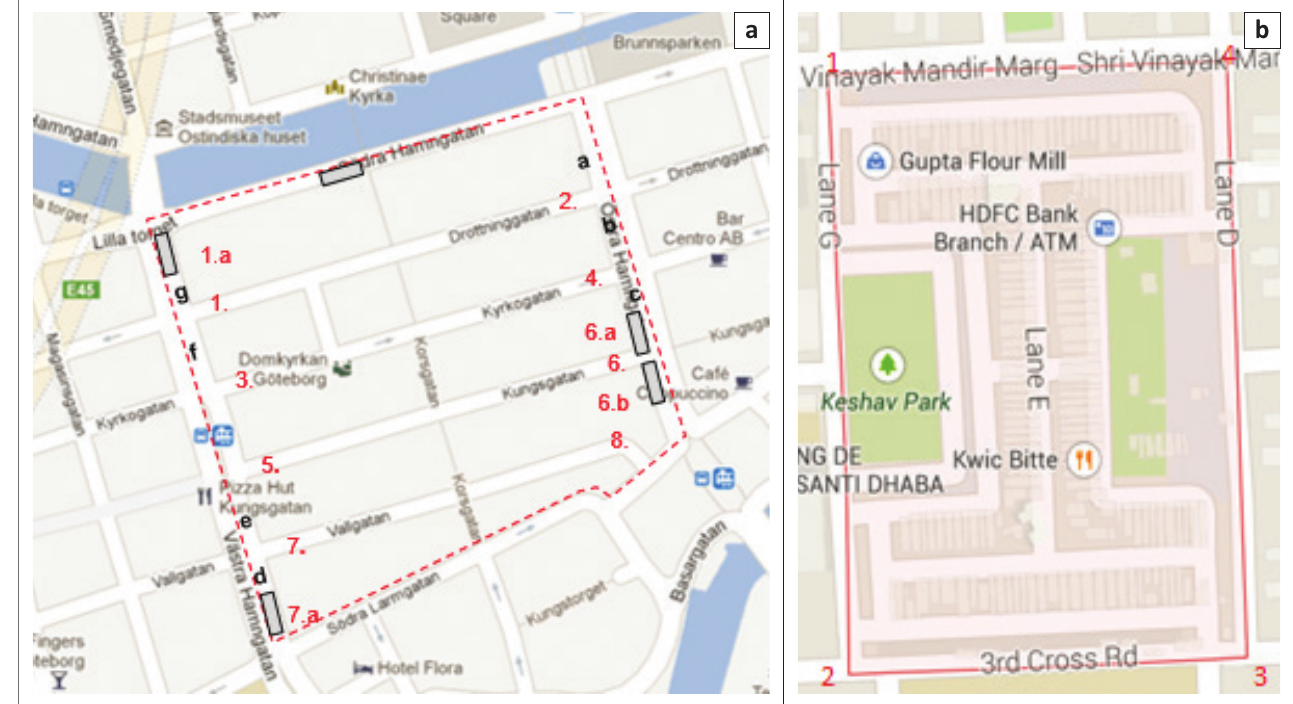
FIGURE 1: Map (a-b) map of study zones at Gothenburg and